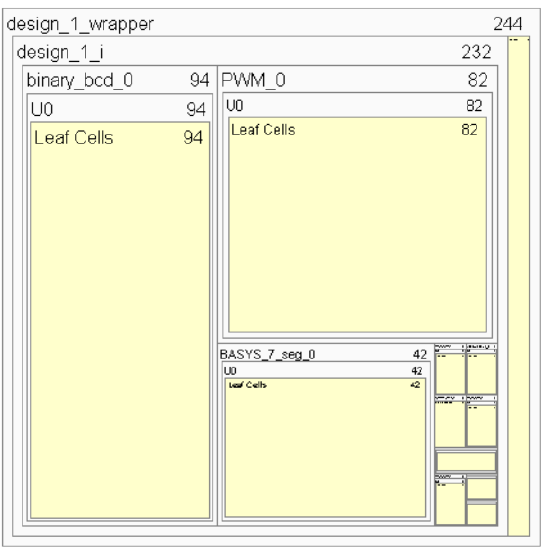
Figure 8. Design